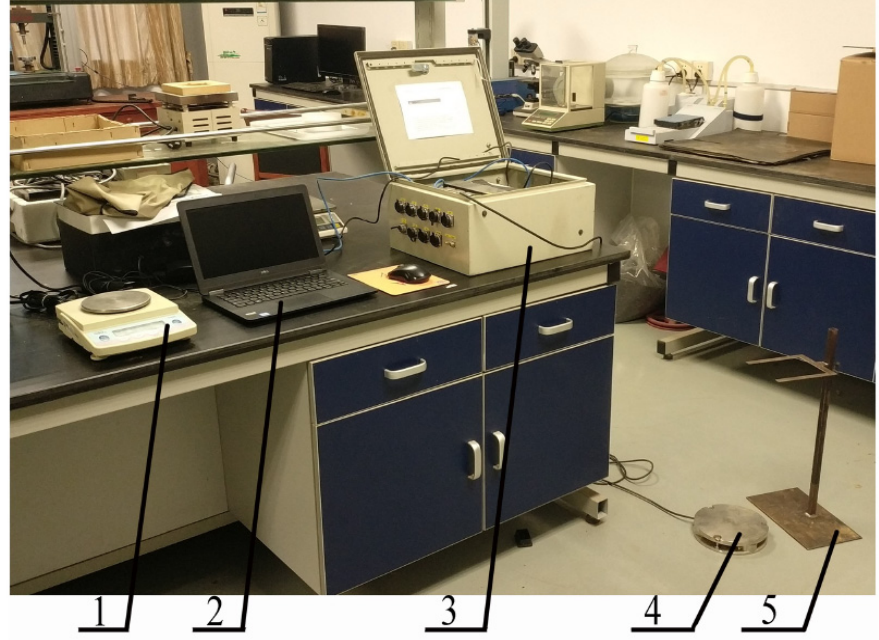
Figure 1. Sweet potato drop impact test system: 1—Electronic balance; 2—Laptop; 3—Signal amplifier; 4—Impact force sensor platform; 5—Ruler frame.